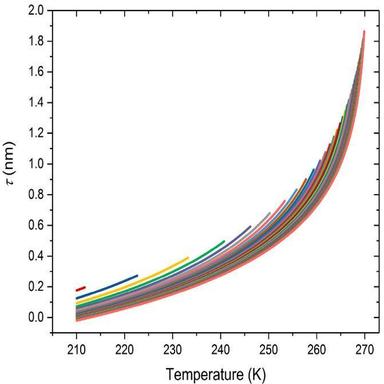
Variation of the thickness τ of the non-frozen layers with temperature in cylindrical pores of different pore diameters from 2 nm to 20 nm in steps of 0.5 nm (from left to right) for water on silica surface. The functions shown are the predictions of Eq. (6). The upper cut-off is given by the temperatures at which transition in the entire pore occurs.